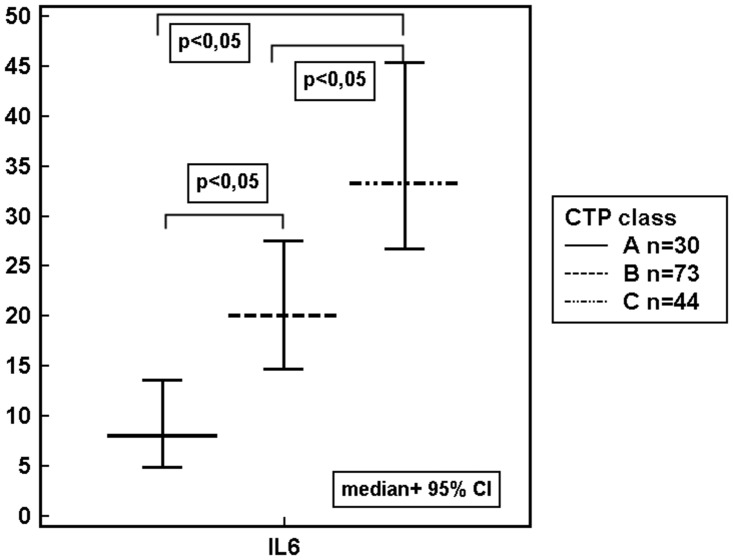
IL-6 concentrations (pg/mL) in ALD patients assigned according to the CTP class.ALD- alcoholic liver disease, 95% CI- Confidence Interval, CTP class- Child-Turcotte-Pugh class, IL- interleukin, p- level of significance.